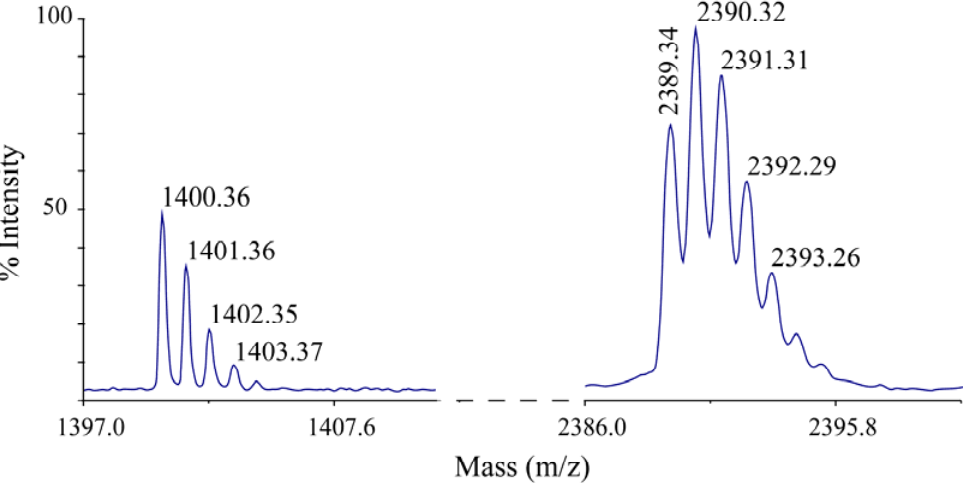
Figure 4. Mass spectrometry analysis of nisin-(1-22)CK digested with trypsin. The fragment with a mass of 1,400 Da (left-hand spectrum) corresponds to the first 12 residues of nisin with an extra –CK attached from the C-terminal end of another nisin peptide. Another fragment (right-hand spectrum) with a mass of 2,389 Da corresponds to residue 1 to 22 with an extra -CK